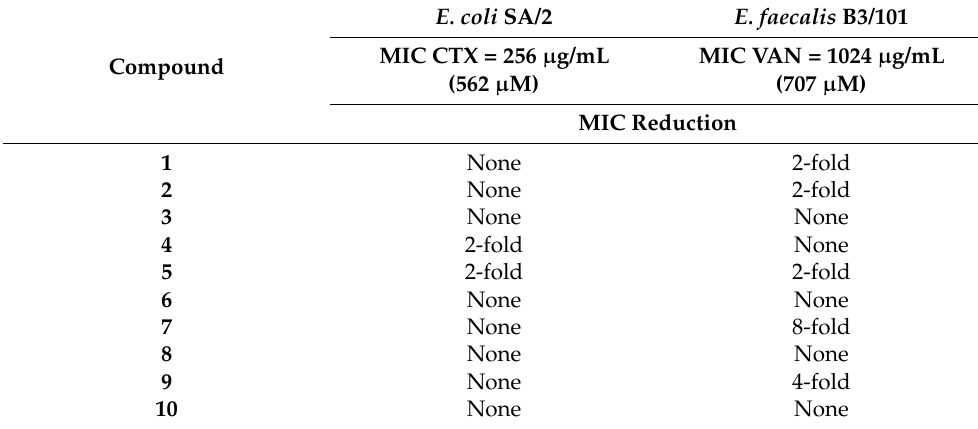
Table 1. Ability of chalcones 1–10 to potentiate the activity of antibiotics in resistant bacterial strains.